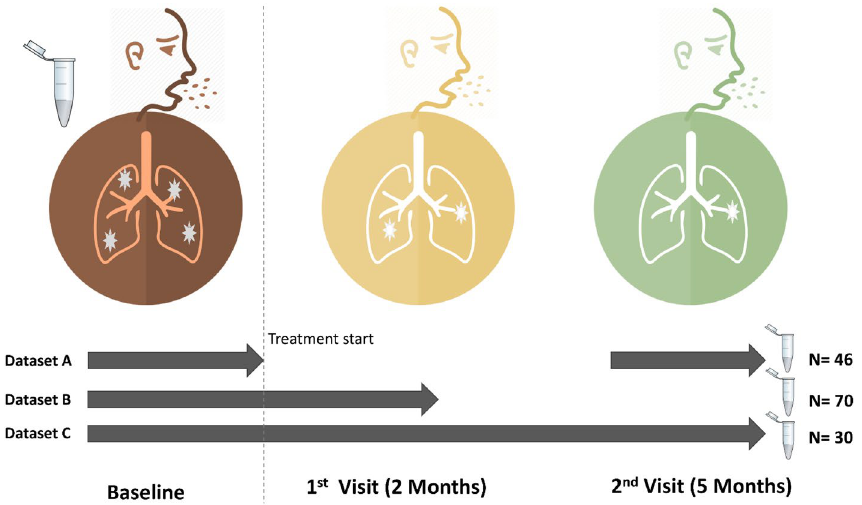
Figure 1. Participants’ enrolment, sampling and treatment response follow-up at months 2 and 5. A total of 120 pulmonary TB patients were enrolled at month 0 (baseline) prior to treatment commencement with first-line anti-TB drugs; of these, 70 had sputum samples at months 0 and 2 (dataset B), 46 had samples at months 0 and 5 (dataset A), while 30 had samples at months 0, 2 and month 5 (dataset C). The microbiome analyses reported in this study focus on dataset C. Dark red, orange and green icons depict months 0, 2 and 5, respectively.